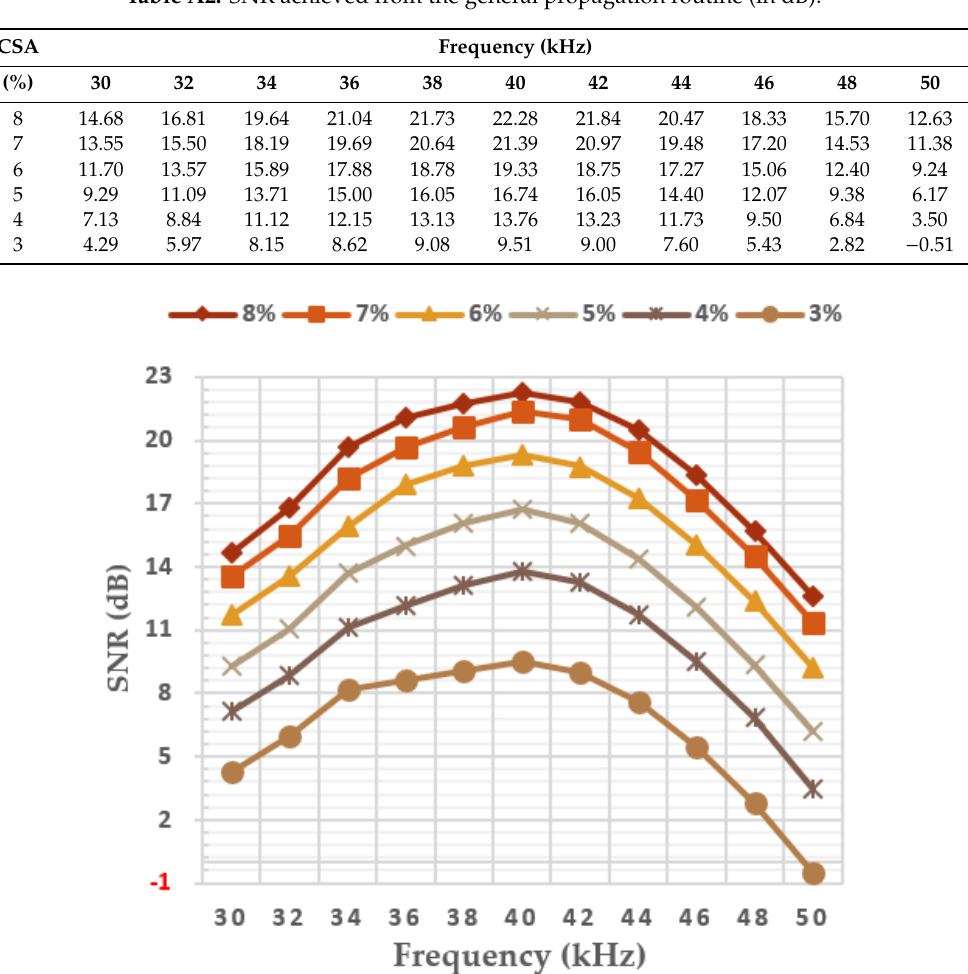
Figure A1. SNR of tests using general propagation routine.